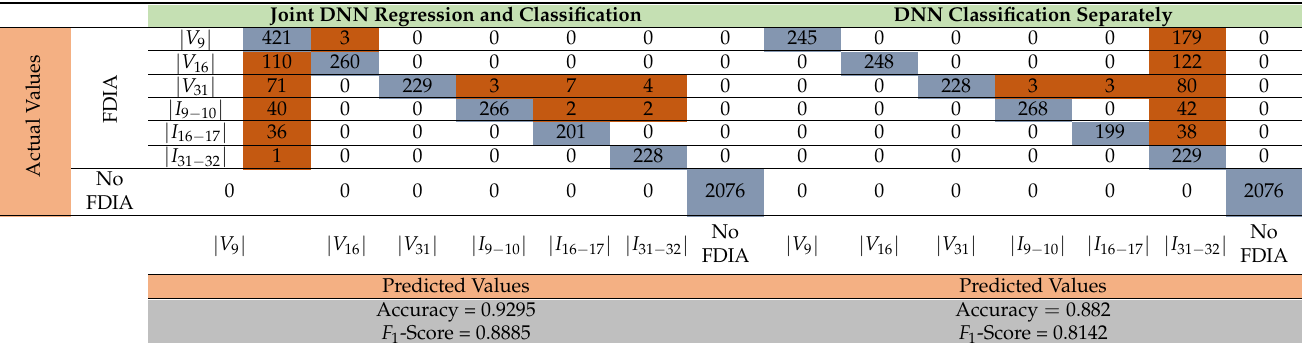
Table 1. Confusion Matrix Showing Bad Data Detection Results and Accuracy Values Obtained Using the Proposed Method and the Binary Classification-only DNN Model when N a = 1200 ( 10% ) ,